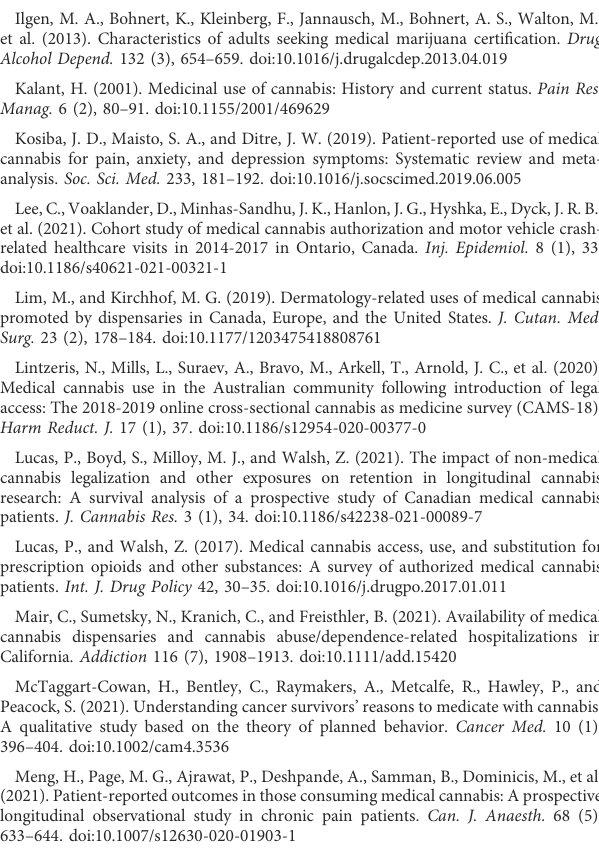
referral and medication substitution: The Canadian context. J. Cannabis Res. 4 (1), 32.